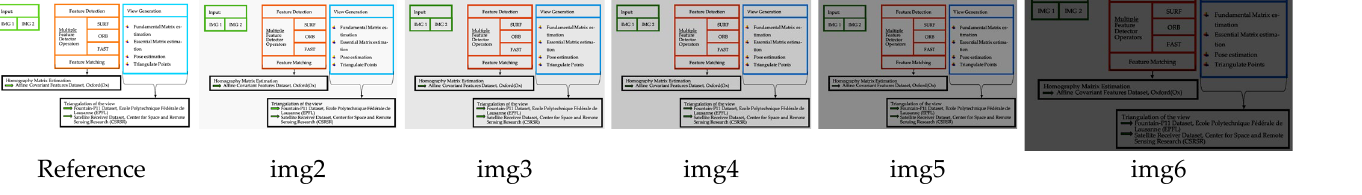
Figure 2. Example structure of image condition changes.